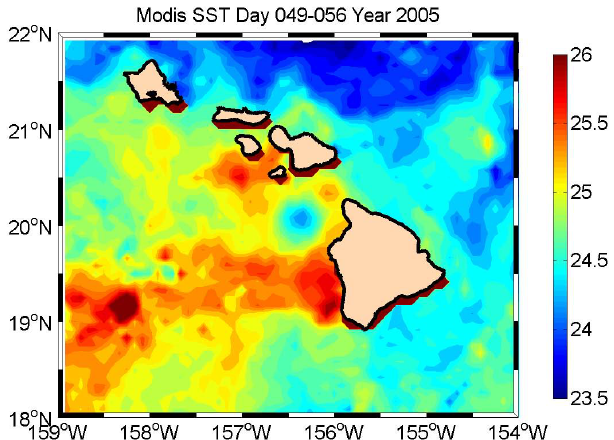
Fig. 1. Composite satellite SST image from the third week (18 to 25) of February 2005, evidencing cyclone Opal ’s cold core between the Big Island of Hawaii and the Island of Maui.